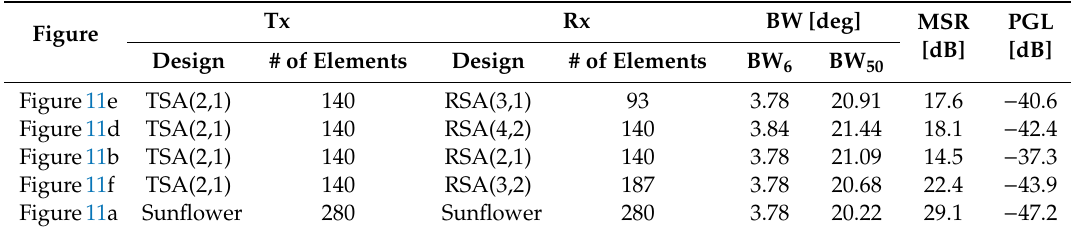
Table 3. Properties of near-field, pulsed-wave responses of spiral array